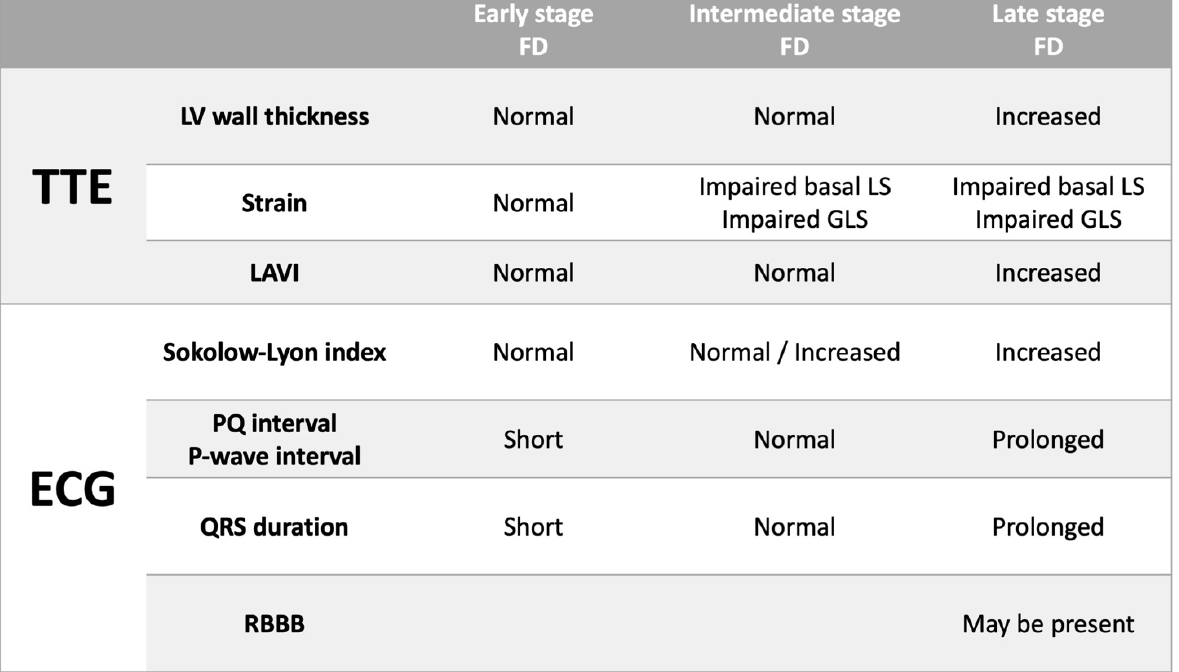
Figure 3. Expected transthoracic echocardiographic (TTE) and electrocardiographic (ECG) changes with progression of Fabry Disease (FD). LAVI = maximum left atrial volume indexed to body surface area. LS = longitudinal strain. GLS = global longitudinal strain. RBBB = right bundle branch criteria.